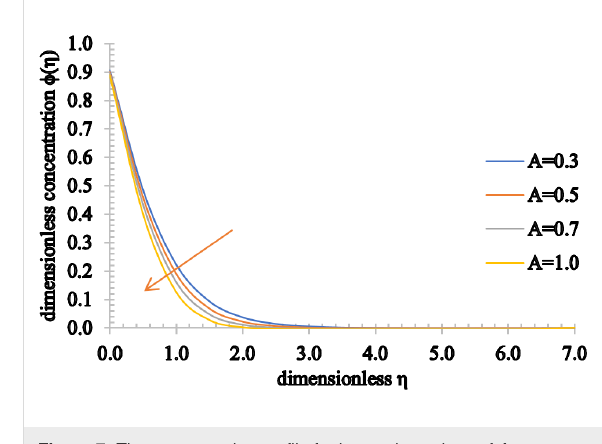
Figure 7: The concentration profile for increasing values of A .